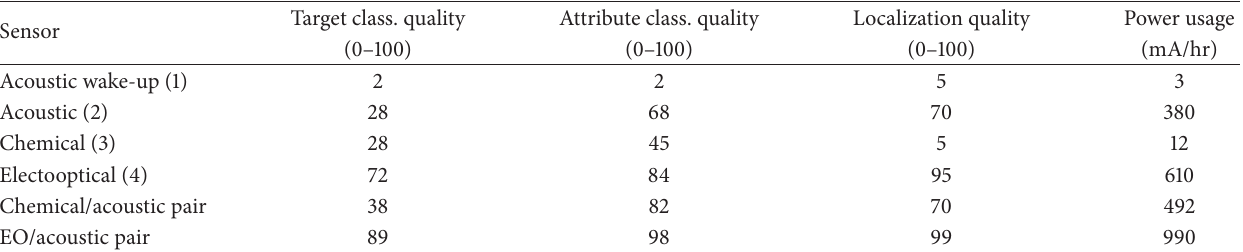
Table 2: Mapping of sensor capabilities to their fuzzy antecedent measurement function.